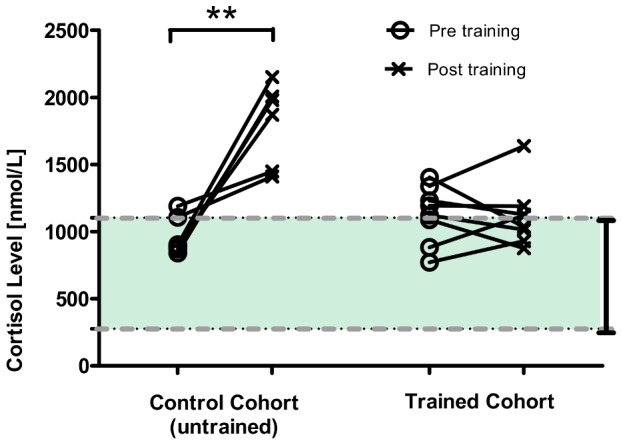
Awake training increased plasma cortisol concentrations in untrained animals, but not in trained animals.Plasma cortisol concentrations measured from the animals (n = 8) at prior- and post-90-minute training session during the Phase 1b period. Results indicate that, at the end of training session cortisol levels are significantly elevated in untrained/control animals (n = 6), while no significant change was observed in habituated animals (paired t-test, **p<0.01). The dash lines highlight the range of normal cortisol concentration observed in cynomolgus monkeys (276 nmol/L to 1104 nmol/L) [52].